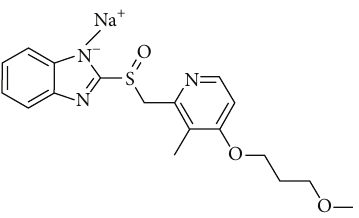
Figure 1: Chemical structure of rabeprazole